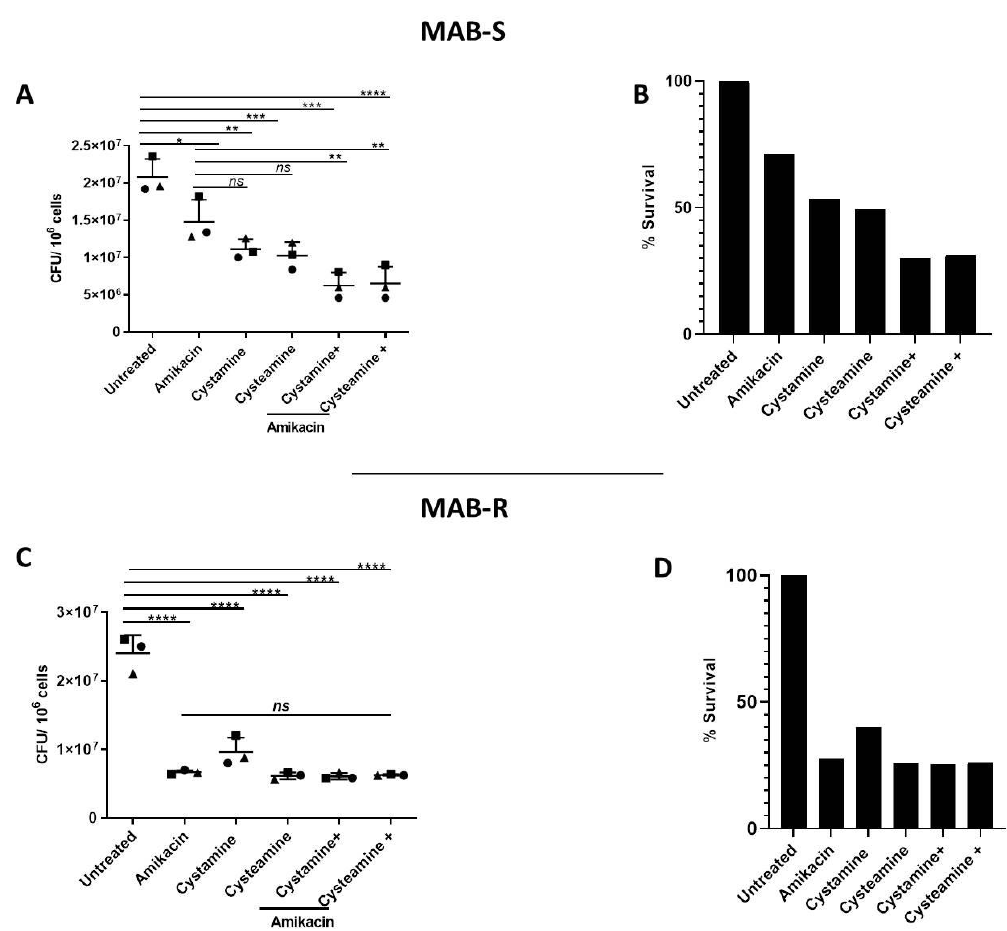
Figure 4. Enhanced effect of cysteamine and cystamine with aminoglycosides in GLS model. GLSs obtained from healthy donors were infected with MAB-S and -R variants at MOI 1:1 and 10:1, respectively, and then treated with different drugs starting at 3 days post-infection treatment of cysteamine and cystamine with amikacin (Sigma-Aldrich) (4 µ g/mL). Total CFUs were determined at 12 days post-infection ( A , C ); * p < 0.05, ** p < 0.01, *** p < 0.005, **** p < 0.001 by one-way ANOVA and Tukey’s multiple comparisons test. Mycobacterial inhibition by the proposed treatments was expressed as a % of survival compared to the untreated group ( B , D ).